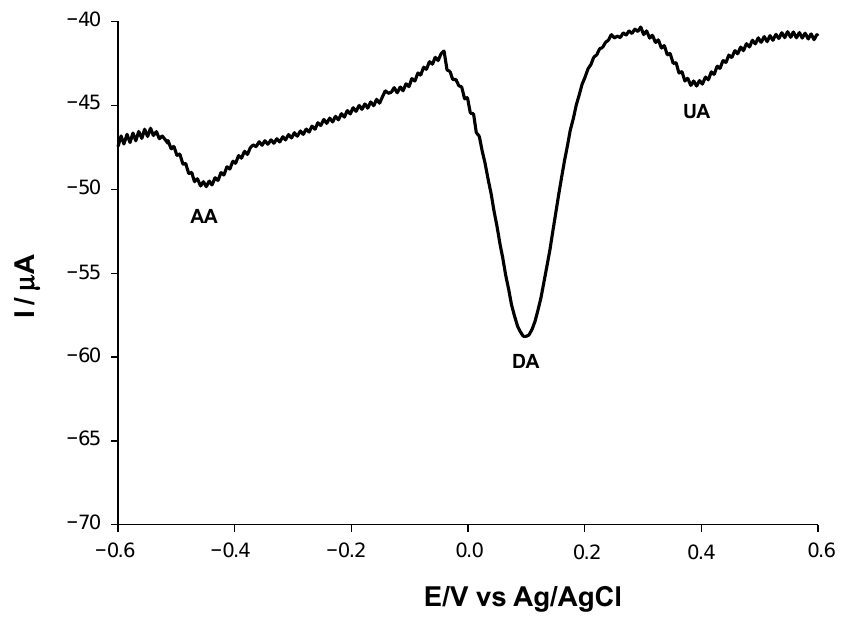
Figure 8. DPVs of 20 µ M DA in the presence of 2 mM AA and 2 mM UA with the Tyr/EDC- NHS/ChitNPs/GPH/SPE biosensor.